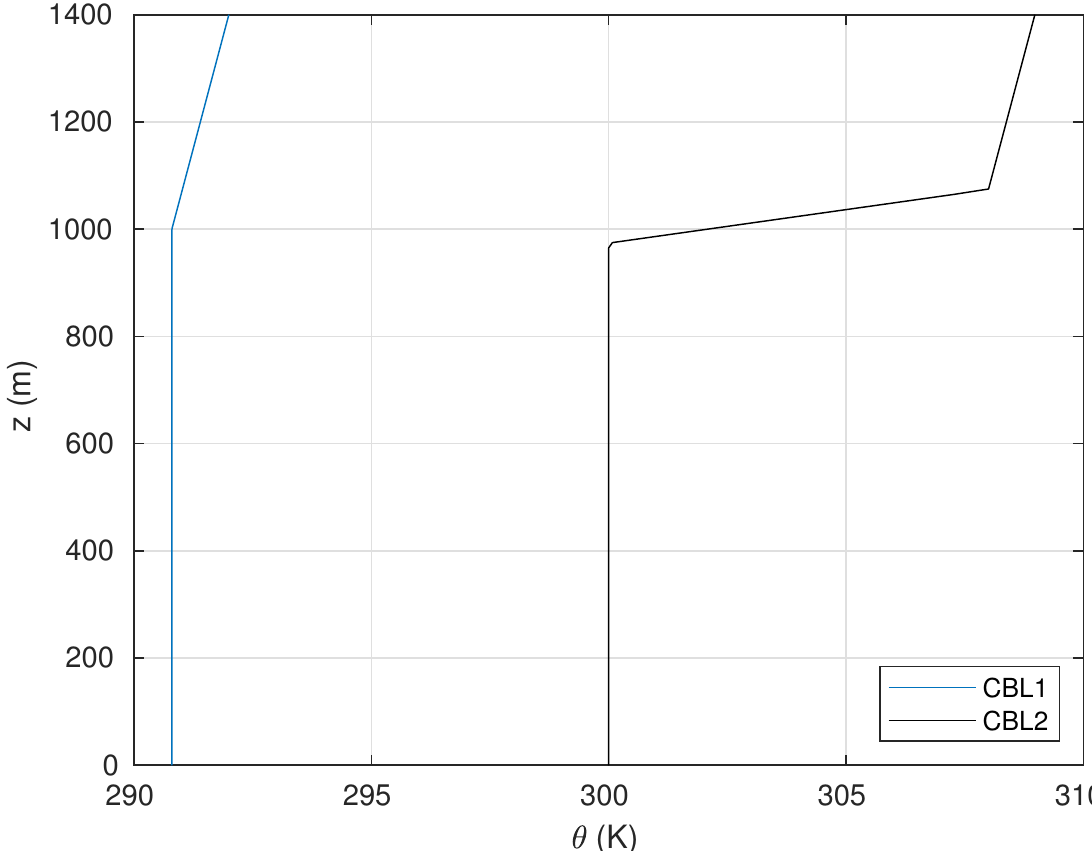
Figure 1. Initial potential temperature profiles for Convective Boundary Layer 1 (CBL1) (blue) and CBL2